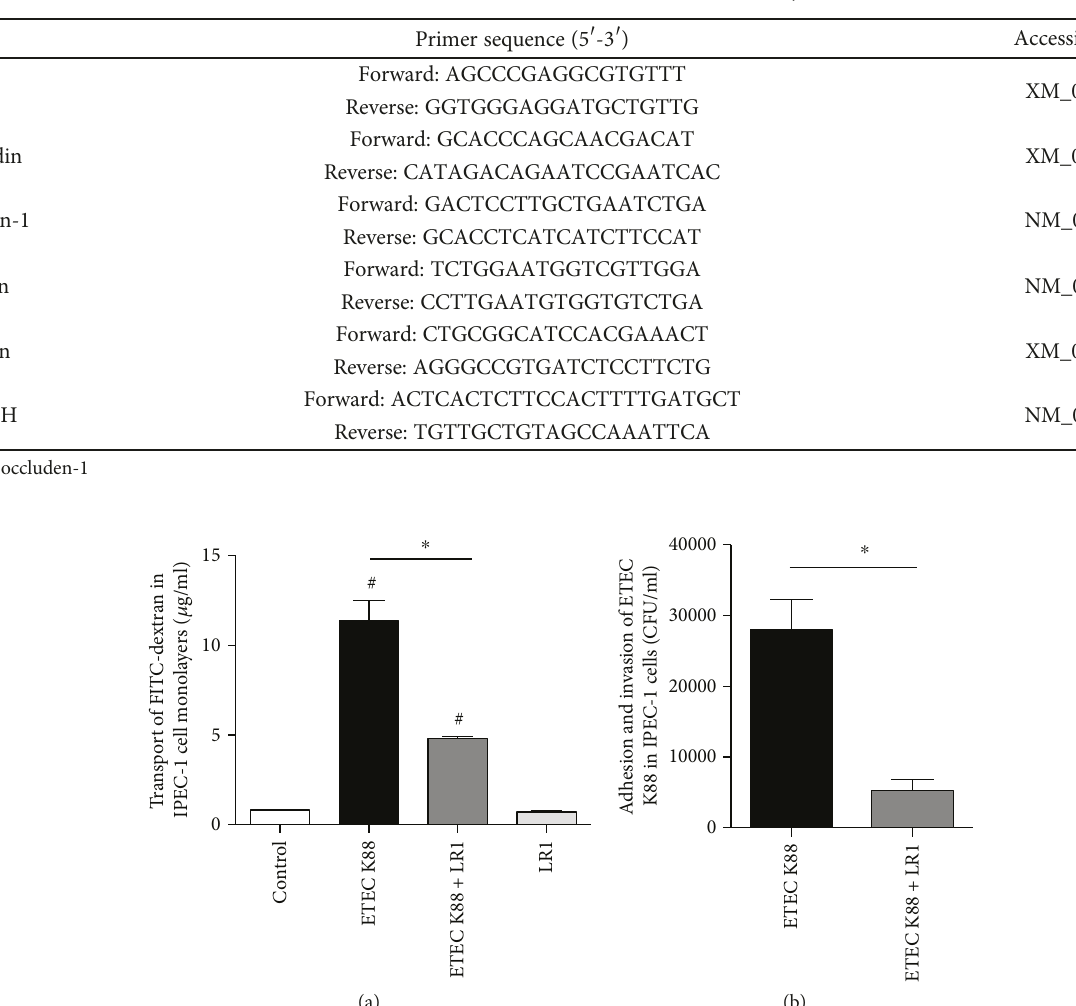
Table 1: Primers used for real-time PCR in this